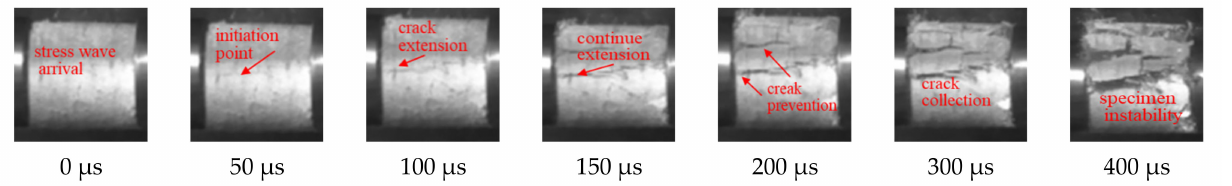
Figure 10. Failure process of specimen taken by high-speed